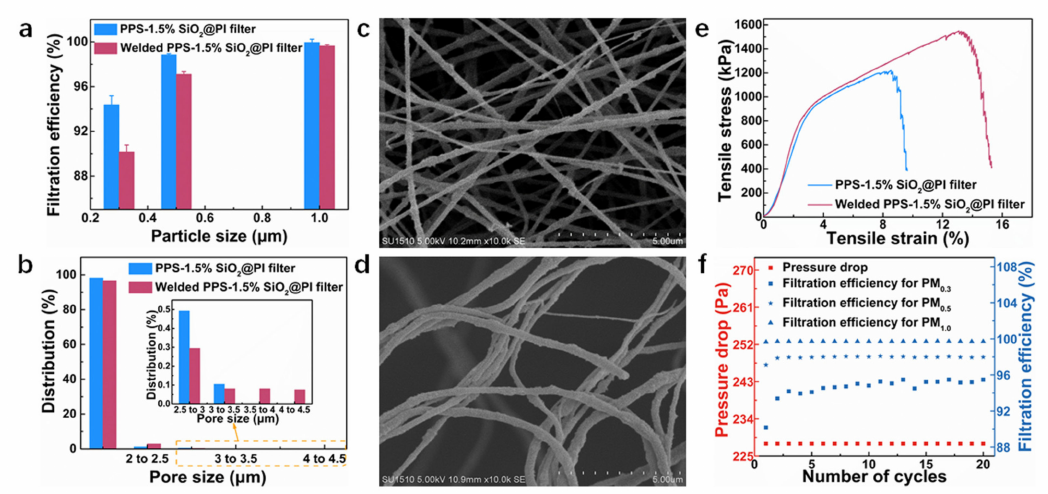
Figure 9. Filtration e ffi ciency ( a ), pore size and its distribution ( b ), and tensile stress–strain curves ( e ) before and after welded PPS–1.5%SiO 2 @PI filters; SEM images of PPS–1.5%SiO 2 @PI filters before ( c ) and after ( d ) being welded by solvent vapor; ( f ) filtration e ffi ciency of welded PPS–1.5%SiO 2 @PI filters in 20